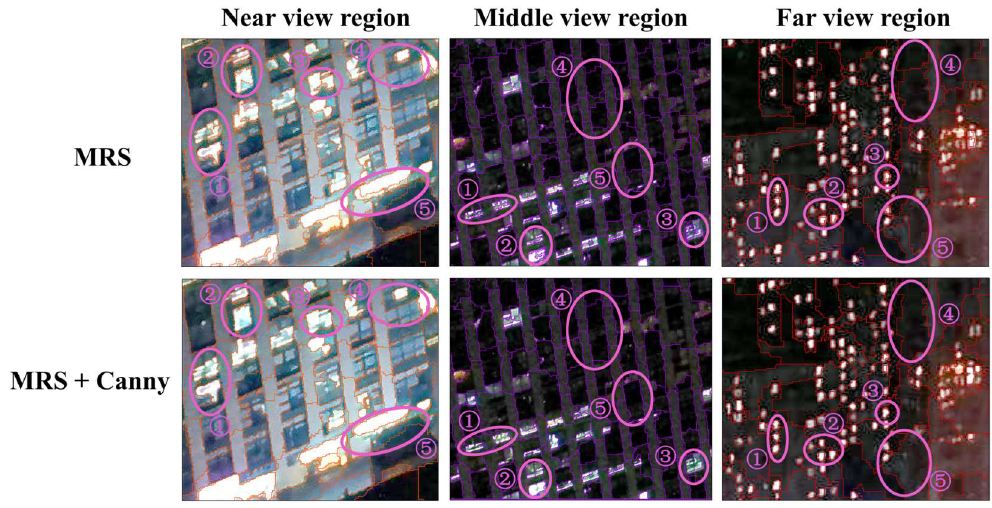
Figure 5. Comparison of segmentation results. (The selected area ① ② ③ indicates the splitting effect of the Window Light, and the selected area ④ ⑤ indicates the split effect between the Building Reflective Light and the Background)